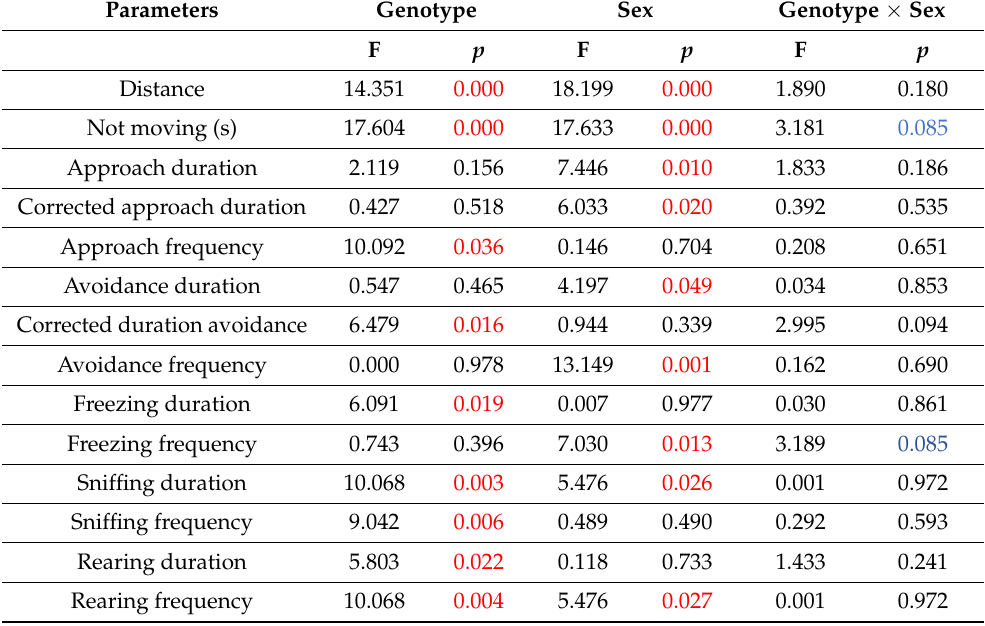
Table 3. Statistical data (results of factorial ANOVA) of fox odor test (Experiment 1). The correspond- ing data are presented on Figure 3. Parameters were analyzed by Solomon Coder by an experimenter blind to the treatment groups. Male and female control and 3xTg-AD mice age at 15-month. Degree of freedom was 1,28. Significant main effects are highlighted in red, while blue colour represents marginally significant